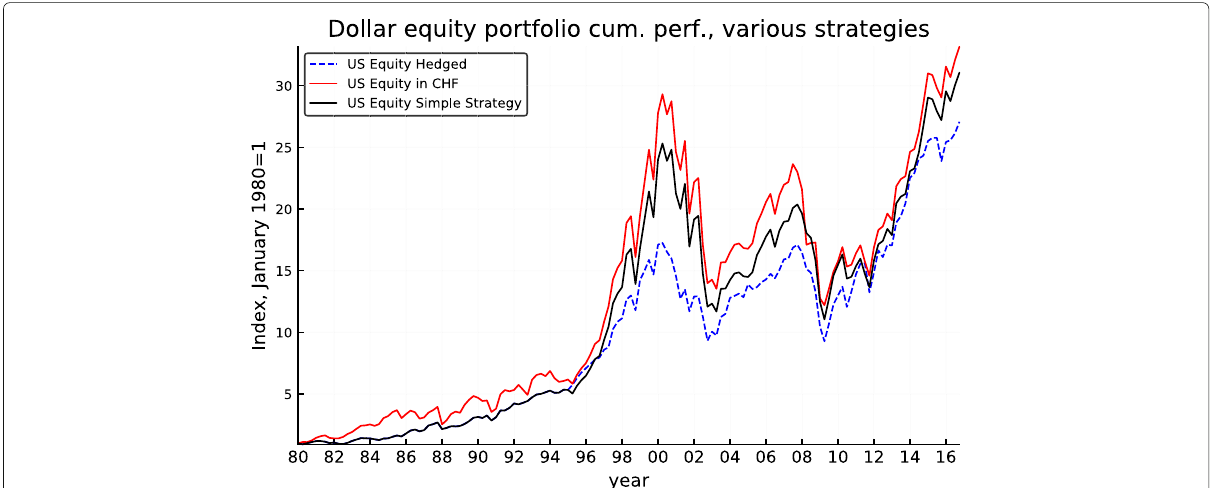
Fig. 8 Dollar equity cumulative performance: unhedged, hedged, and simple